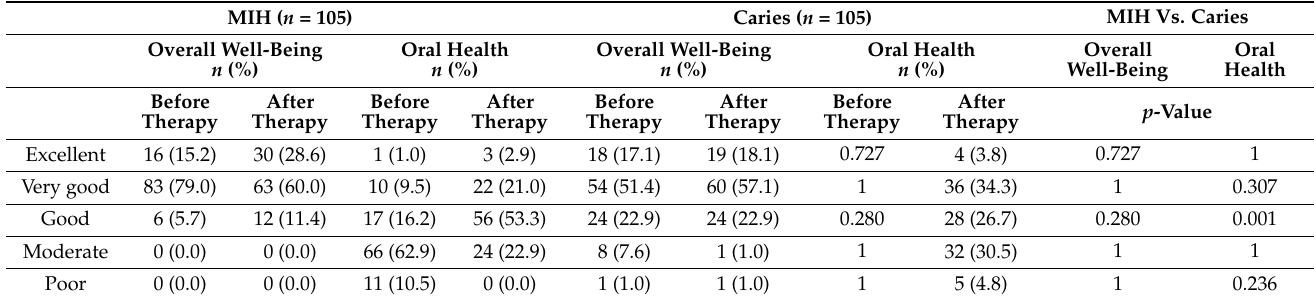
Table 4. Comparison of Questions concerning Overall well-being and Oral Health ( n = 210 patients) Before and After Therapy.